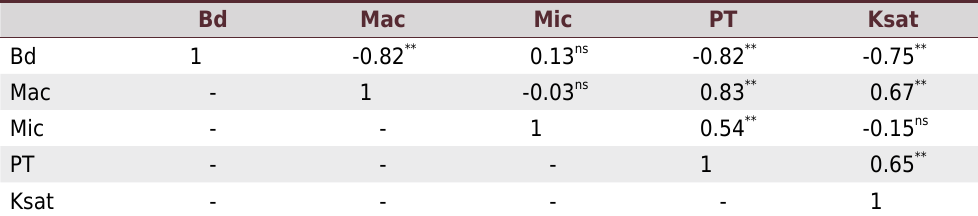
Table 7. Pearson correlation between soil physical properties: soil bulk density, macro and microporosity, total porosity, and saturated hydraulic conductivity